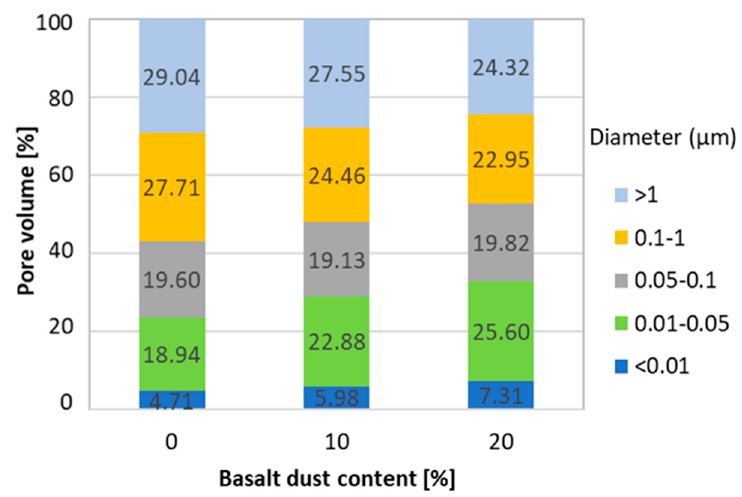
Figure 9. Share of pores of a certain diameter in the total pore volume in cement mortar with basalt dust additive [46].